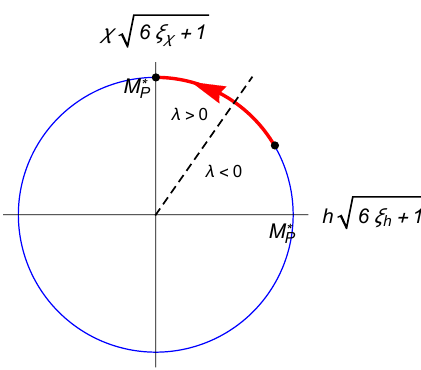
Figure 1. The bounce con(cid:12)guration in terms of the Higgs ( h ) and dilaton ( (cid:31) ) (cid:12)elds. An arrow points the direction in which r